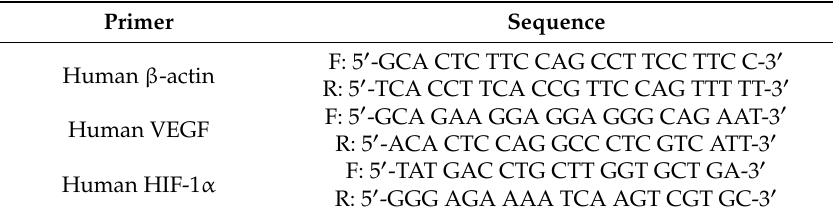
Table 2. Sequences for primers used in